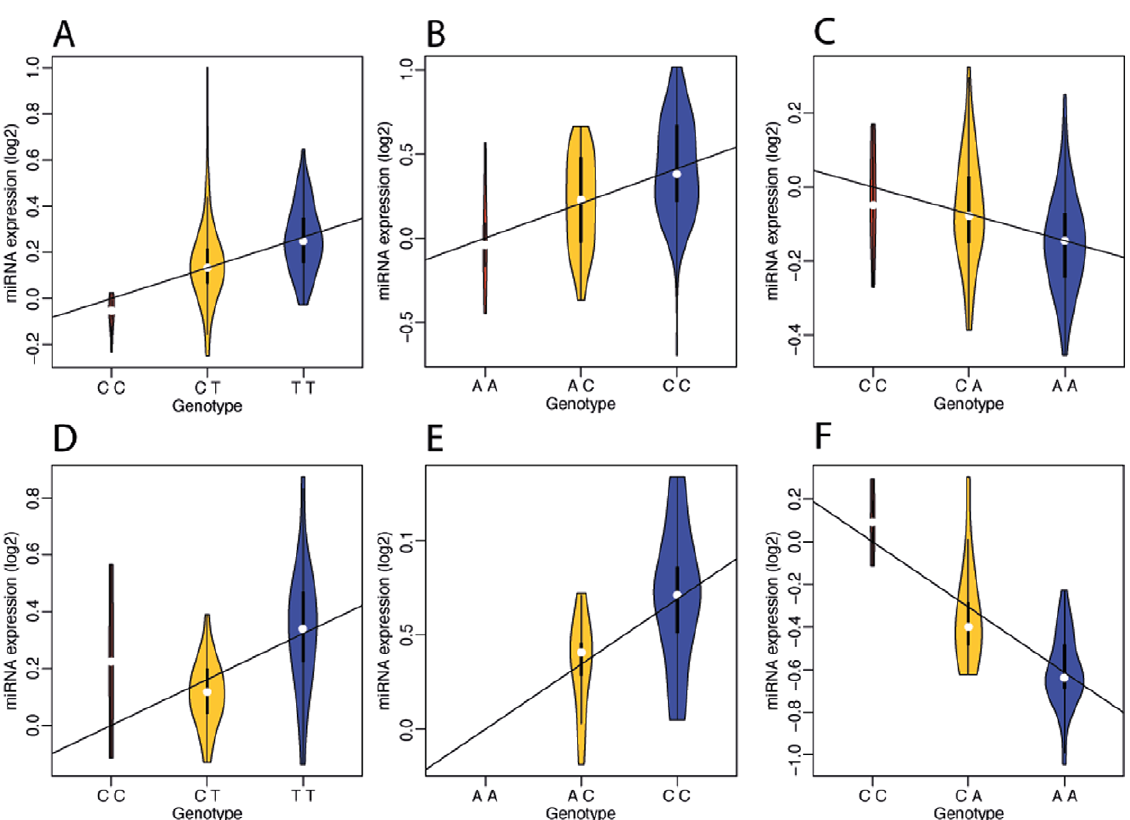
Figure 3. Genetic effects in replicated miRNA eQTLs in abdominal adipose tissue (see Materials and Methods section for criteria). The violin-plot represents the density of miRNA expression relating to the SNP effect for each genotype (variability relating to the other fixed effects was regressed out); the line represents the fixed-effect coefficient ( b ) relating to the SNP effect. A) Primary study hsa-miR-1255a :rs1822168 B) Primary study hsa-miR-618 :rs1716543 C) Primary study hsa-miR-146a* :rs2961920 D) Replication study hsa-miR-1255a:rs1822168 E) Replication study hsa-miR-